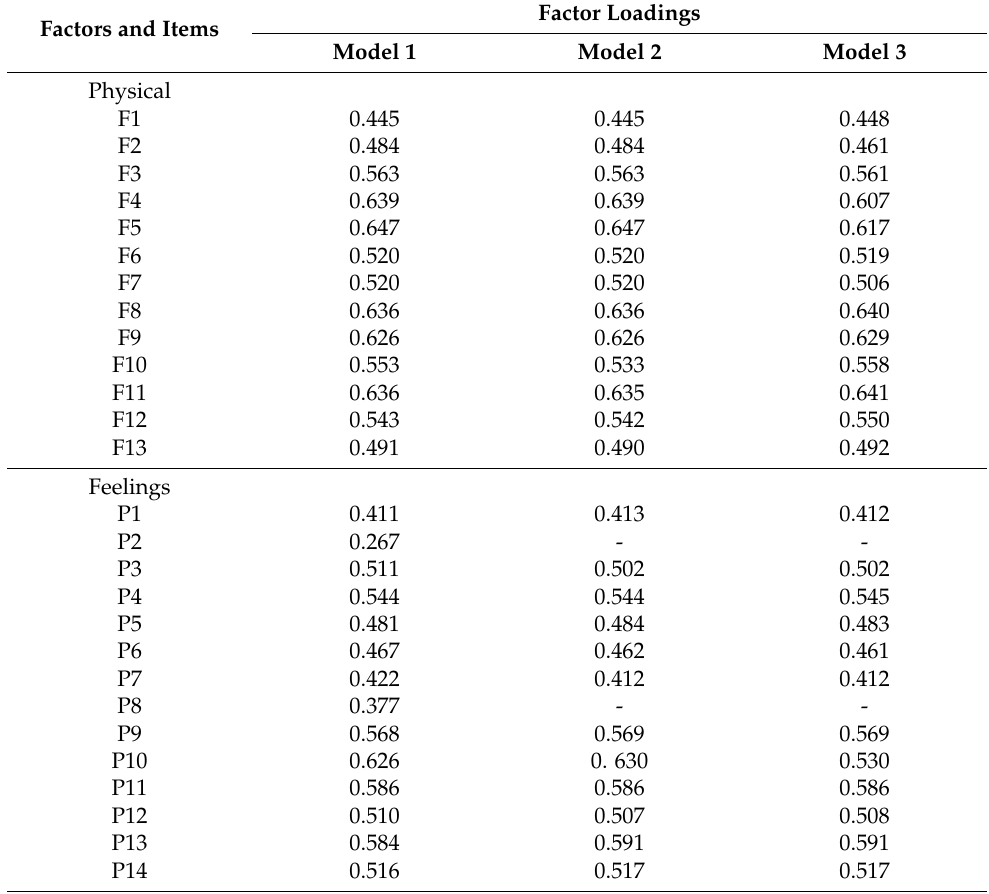
Table 2. The standardized factor loadings for model 1, model 2, and model